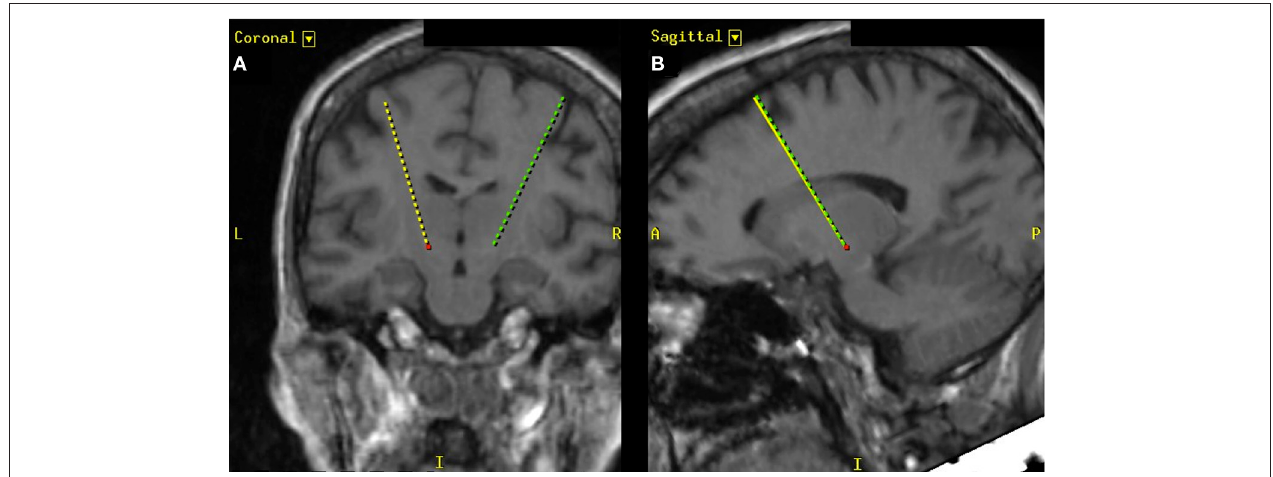
FIGURE 1 | T2-weighted MR image depicting the targeting trajectory (dashed lines) for the placement of deep brain electrodes. (A) Depiction of electrode trajectories in the coronal plane and (B) depicts the electrode trajectory in the sagittal plane. The red dot indicates the position of the left STN.